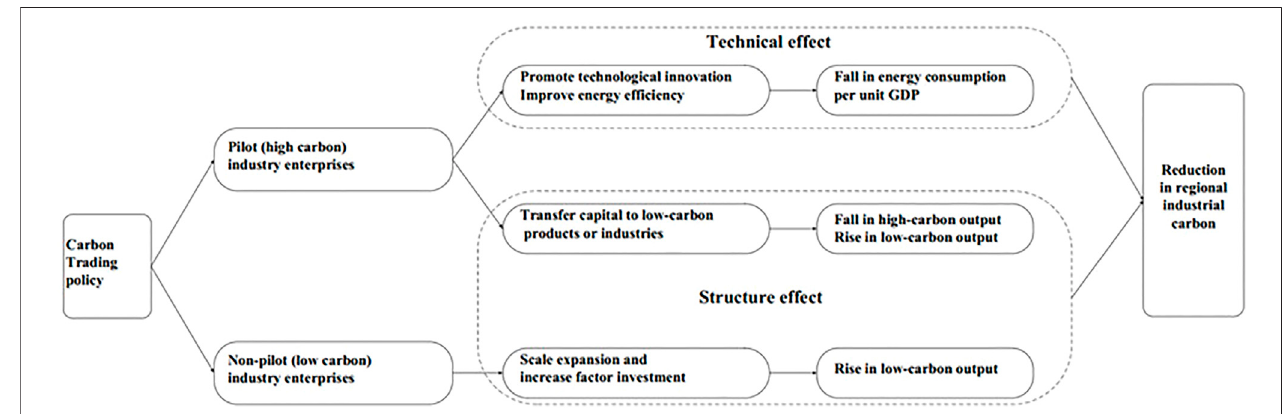
FIGURE 4 | The mechanisms by which carbon emissions trading policies promote reduced regional industrial carbon emissions. This leads to Hypothesis 3.